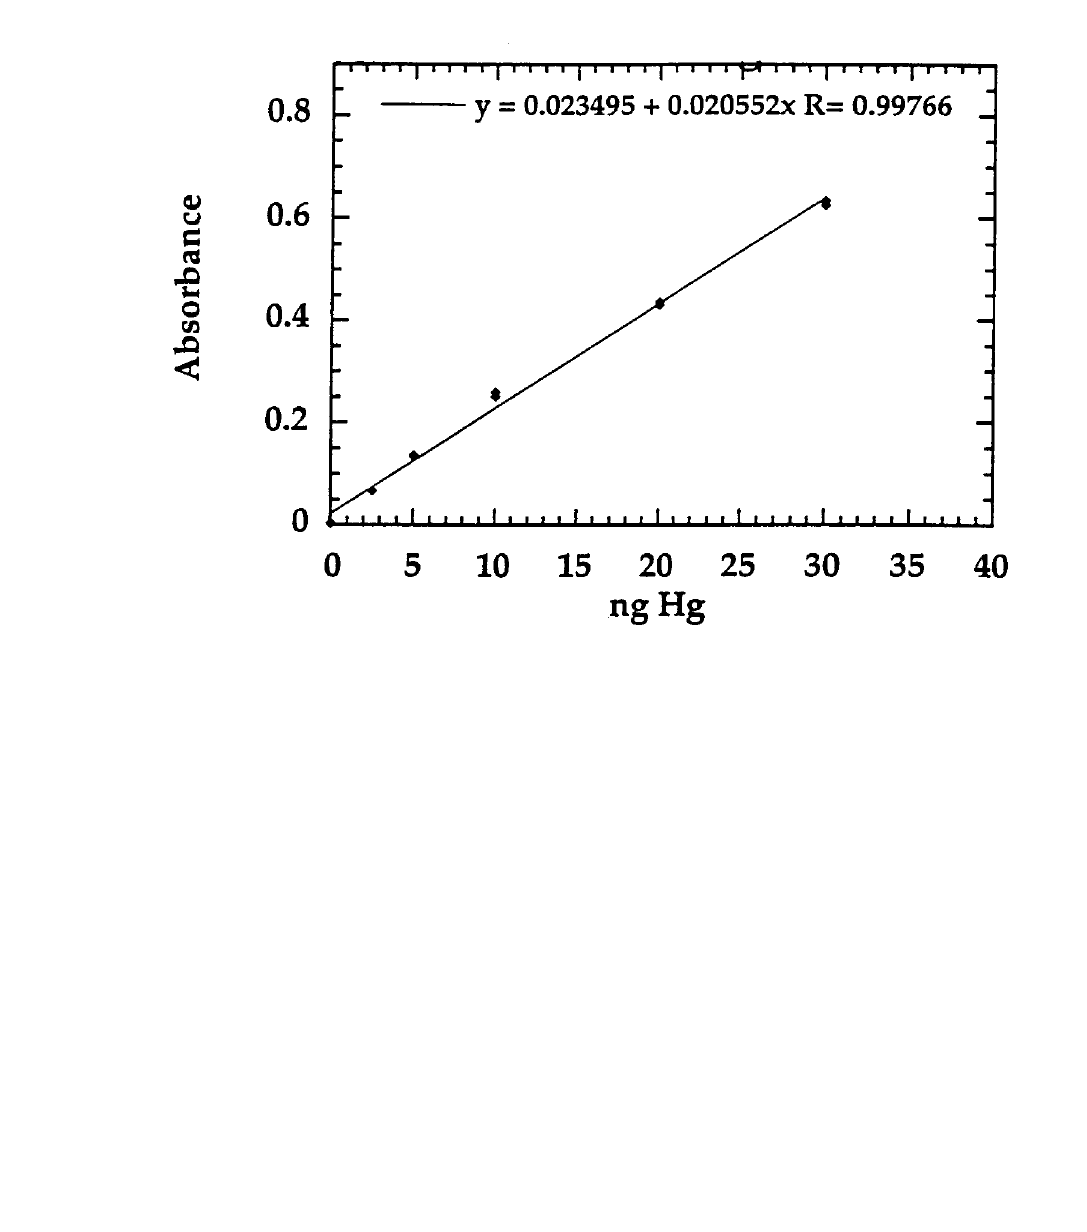
PRIMARY CALIBRATION CURVE USING THE DMA 80 IN FIELD ANALYSIS